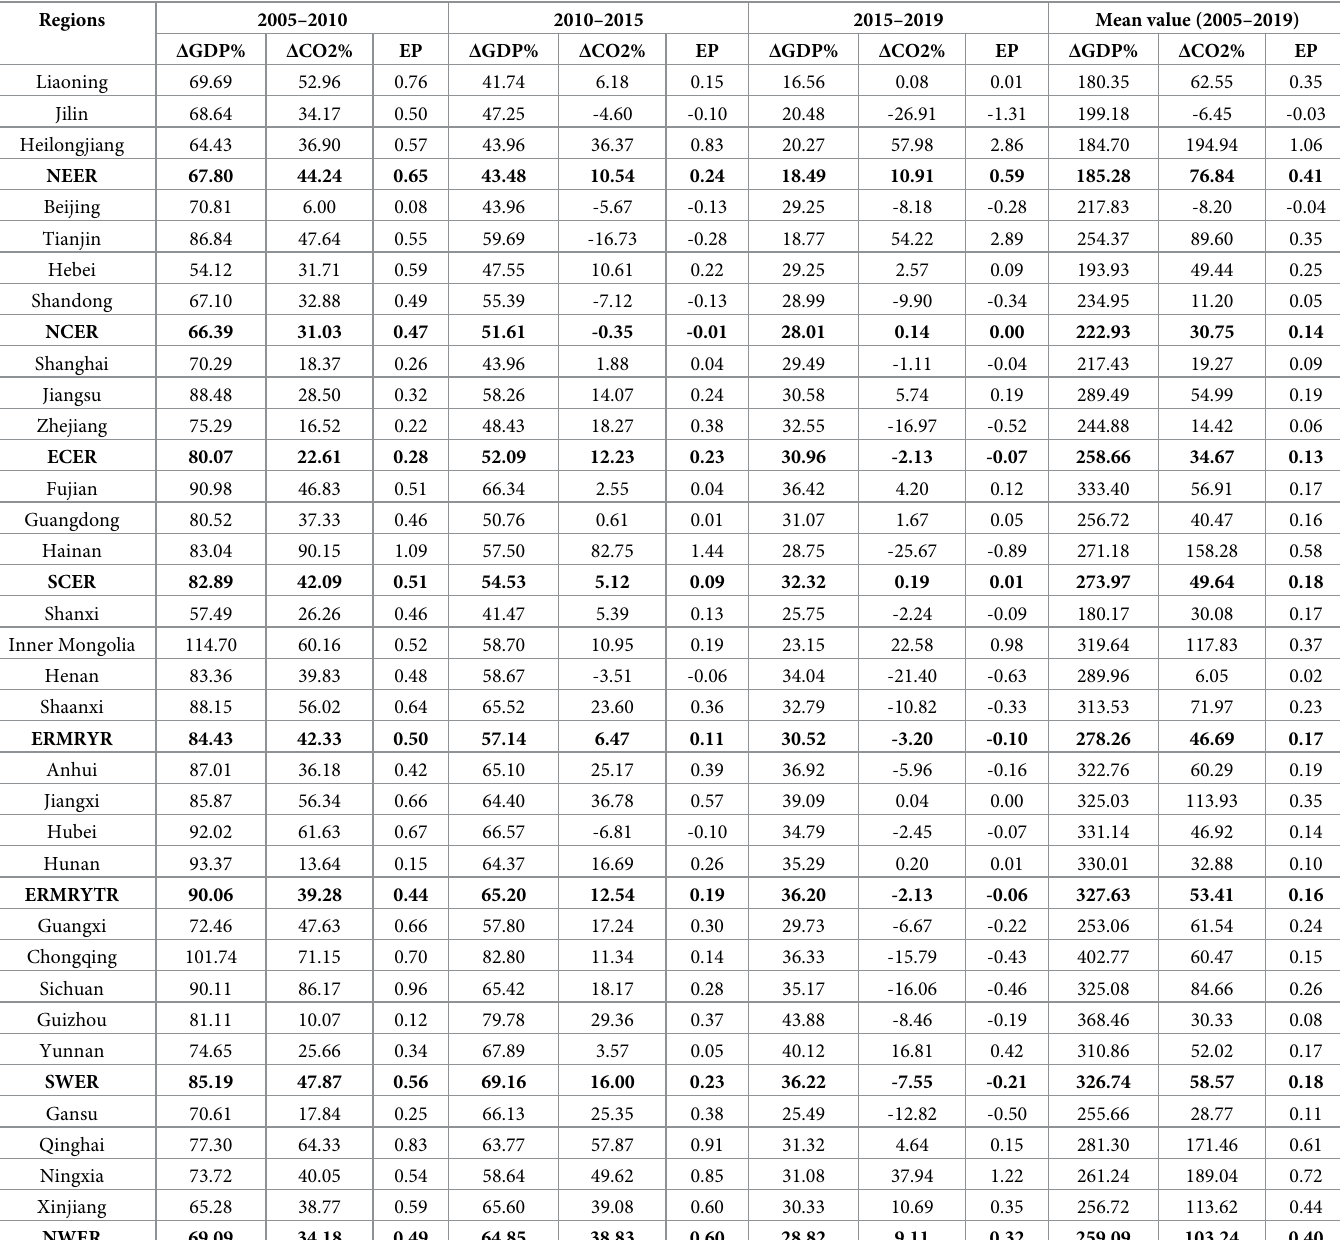
Table 4. One-dimensional decoupling state for China’s eight economic regions over 2005–2019.